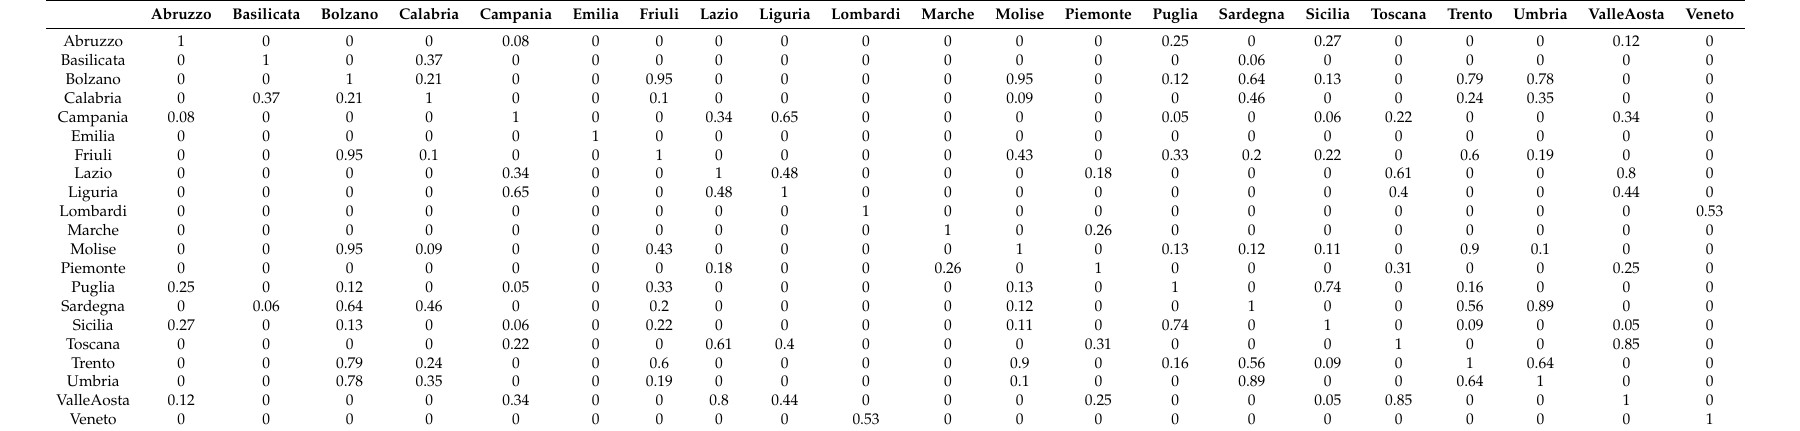
Table A3. Similarity values of Hospitalized with Symptoms network in the second week.